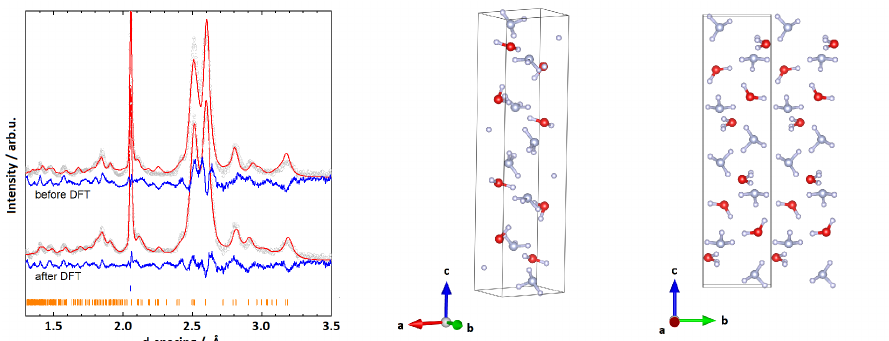
Figure 2. ( Left ): Rietveld fits to experimental data and respective structures for the monoclinic cell P2 1 / c (I) with a = 4.379 ( 3 ) , b = 4.502 ( 4 ) , c = 17.770 ( 5 ) , and β = 92.39 ( 2 ) deg. Grey (red, blue) graphs represent diffraction data (Rietveld fits, residuals). Orange ticks represent peak positions of P2 1 / c (I), blue ones parasitic peaks from anvils. ( Right ): The model obtained from the Rietveld refinement. Red (blue, white) spheres represent oxygen (nitrogen, hydrogen) atoms.